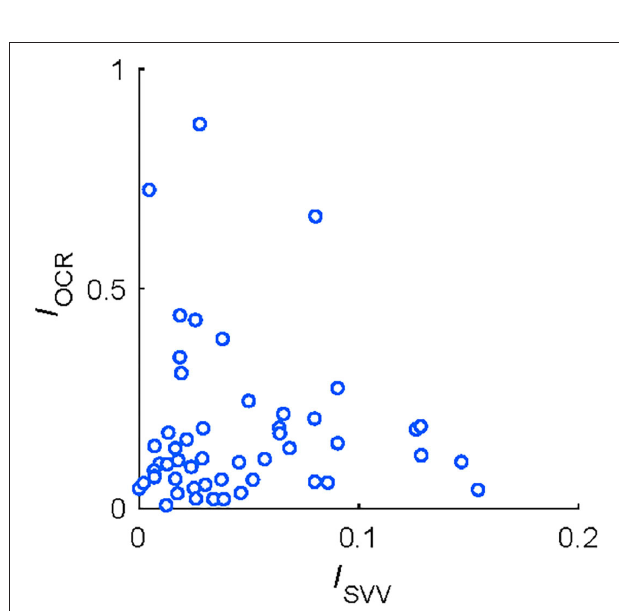
FIGURE 4 | Correlations between functional asymmetry in HT-SVV ( I SVV ) and in OCR ( I OCR ) tests from 51 participants.